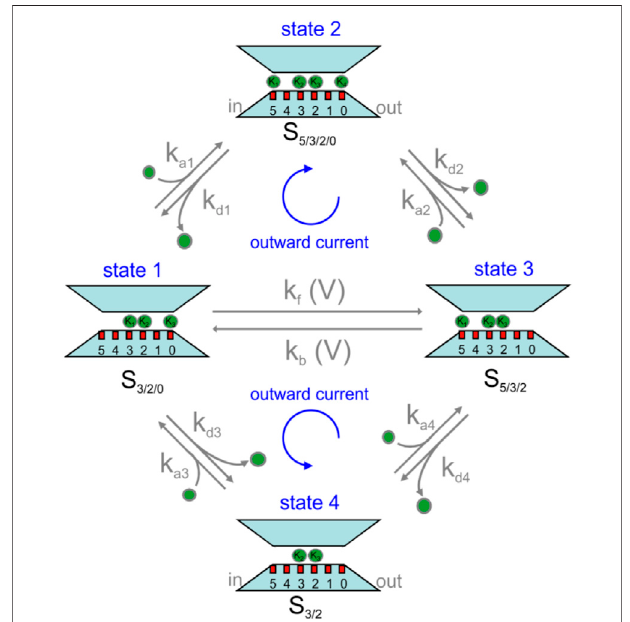
FIGURE 4| Permeationkinetic model for KcsA channel proposed in this article. See text for